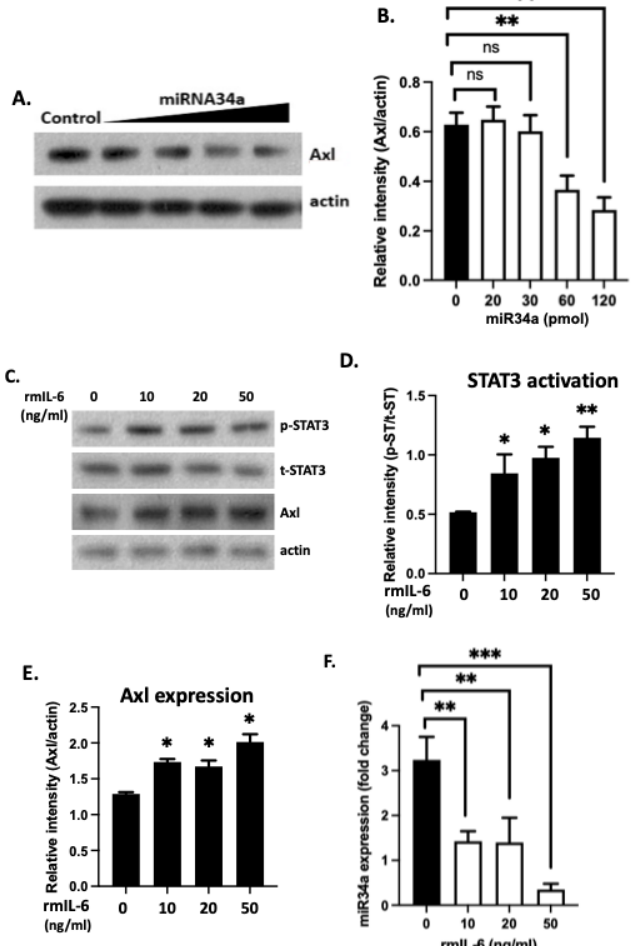
Figure 6. miRNA34a is a negative Axl regulator in mesangial cells. ( A ) Mesangial cells were treated with increased concentrations miRNA34a mimics. Cells were lysed in RIPA buffer after two days. Axl expression was analyzed by Western blot. Beta actin blot serves as an internal loading control. ( B ) Axl expression levels were quantified. ( C ) Primary kidney cells were treated with increased concentration of rmIL-6 for 16 hrs. Cells were then lysed in RIPA buffer and analyzed for STAT3 activation and Axl expression. Quantified data are presented in ( D , E ), respectively. ( F ) Expression of miR34a from the IL-6 treated primary kidney cells was analyzed. Experiments were repeated twice. Mann–Whitney